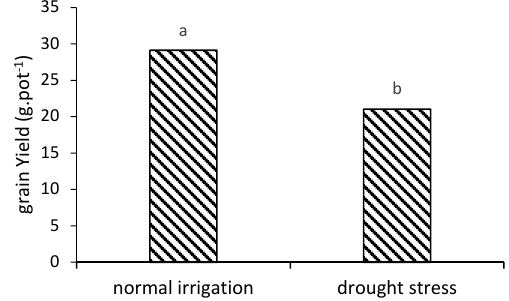
Fig 5. Effect of irrigation regime on grain yield. Means by the uncommon letter in each column are significantly different according to Duncan test (p<0.05).